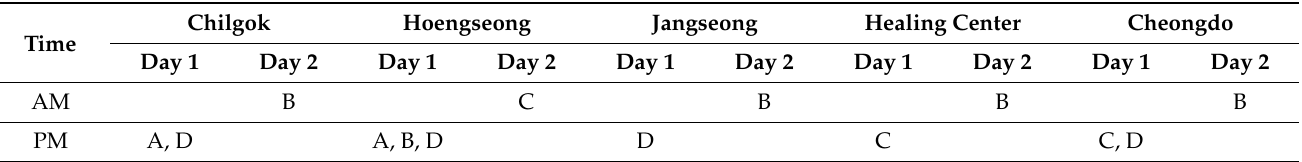
Table 3. Schedule of forest healing programs for one night and two days for each institution from 2018 to 2020.